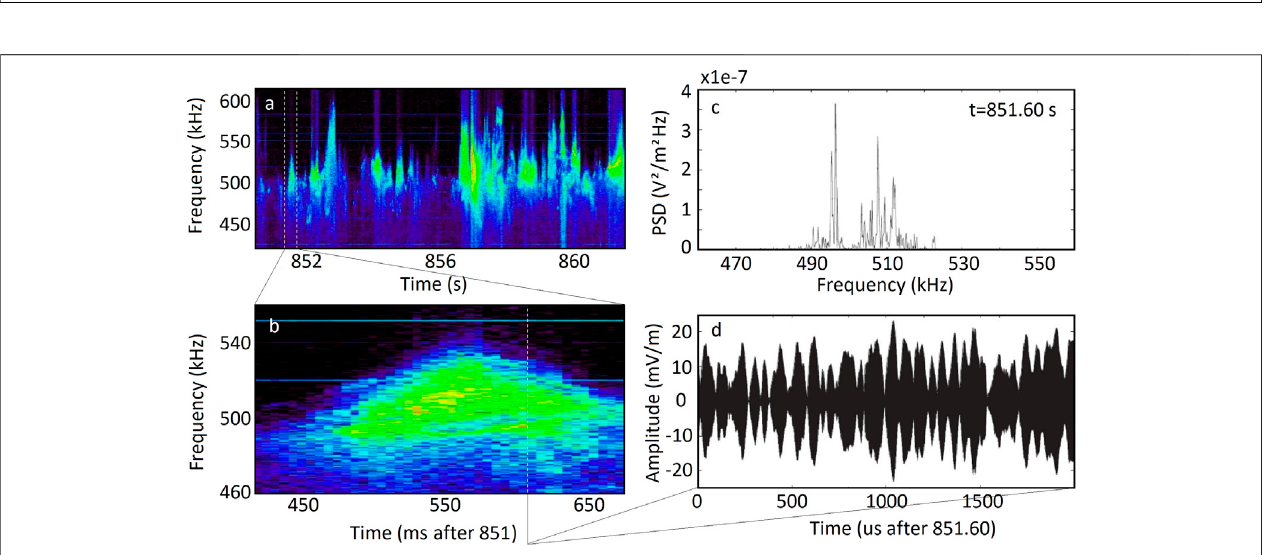
FIGURE 5 | Adapted from LaBelle et al. (2010): Langmuir wave electric fi elds measured with a 30-cm double-probe antenna at 967 – 894 km with the TRICE sounding rocket launched from Andoya, Norway on December 10, 2007. Left panels: overview spectrogram showing Langmuir wave bursts (top) , and zoomed-in spectrogram showing Langmuir wave structure (bottom) . Right panels: selected spectrum showing a forest of peaks at and below f p (top) , and time series waveform showing typical Langmuir wave modulations.